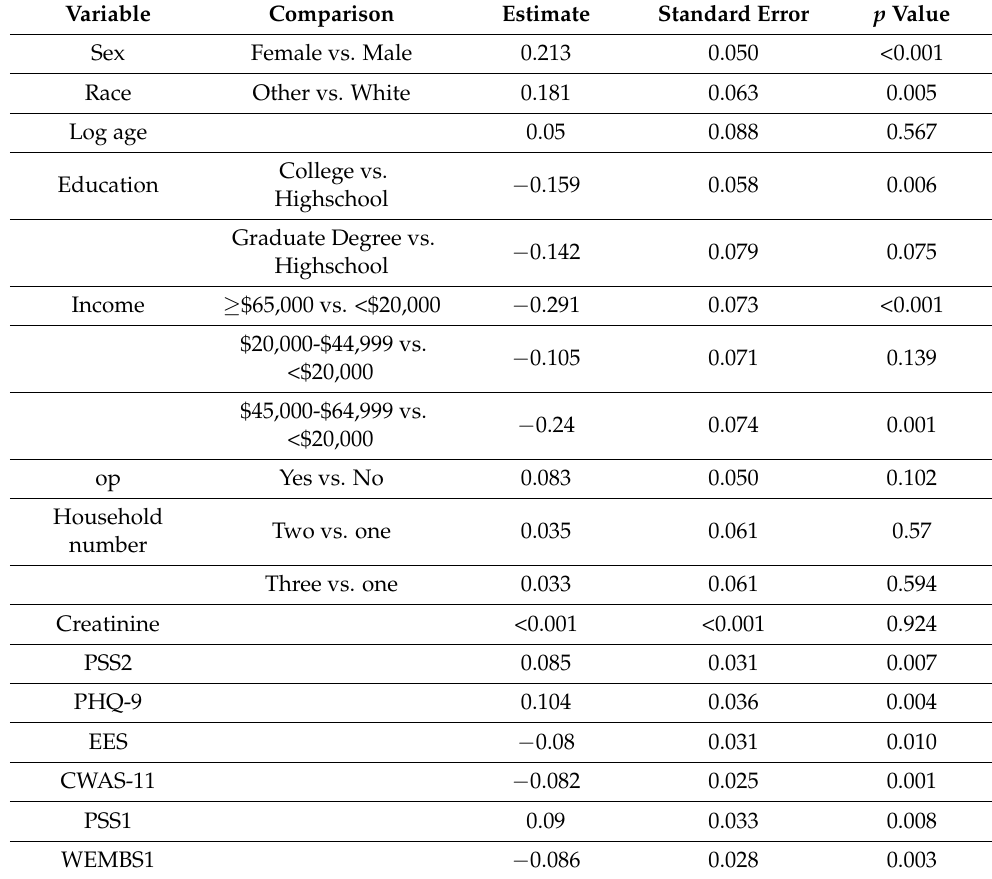
Table 5. Univariable linear regression of demographics, psychosocial and work scales to predict 3 MT level.